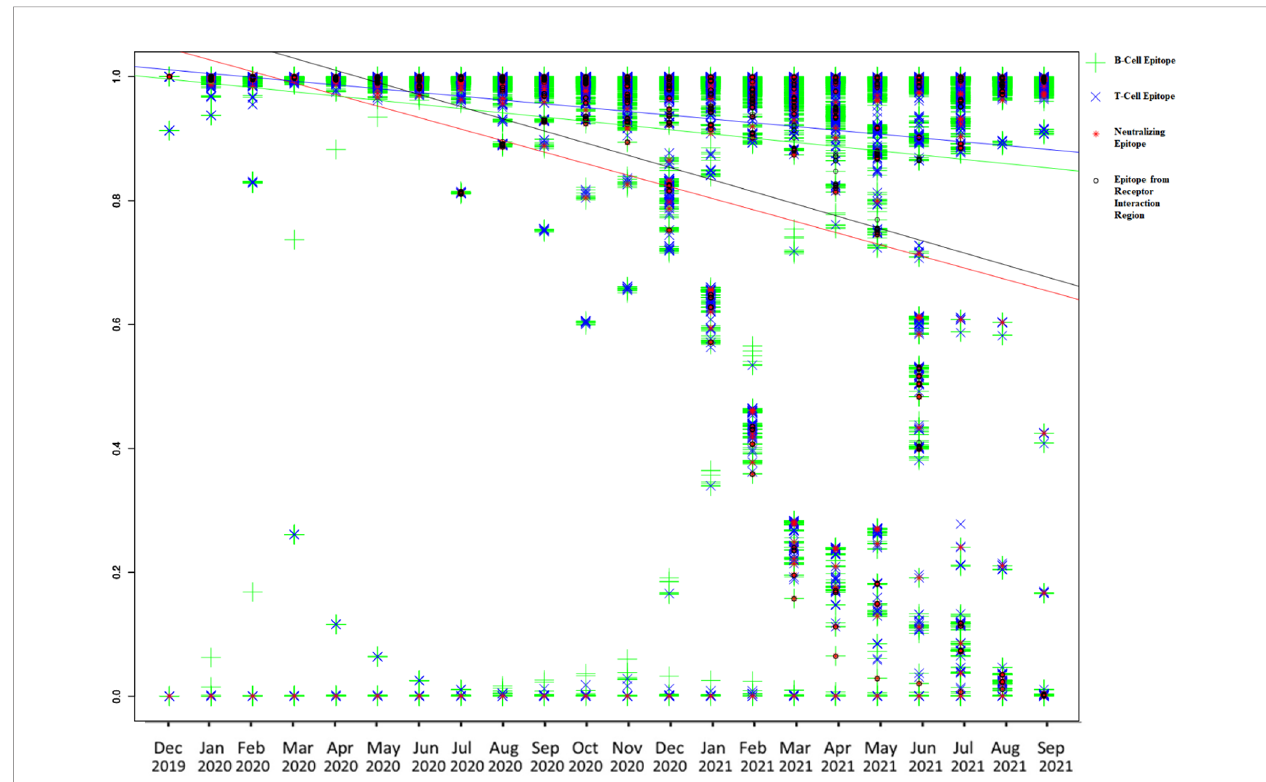
FIGURE 2 | Graphical representation of monthly conservation and linear regression analysis of B-cell, T-cell, EIR, and neutralizing epitopes to demonstrate the trend of conservation. Blue line color is for T-cell epitopes, the yellow line is for B-cell epitopes, black line is for EIR, and the red line is for neutralizing